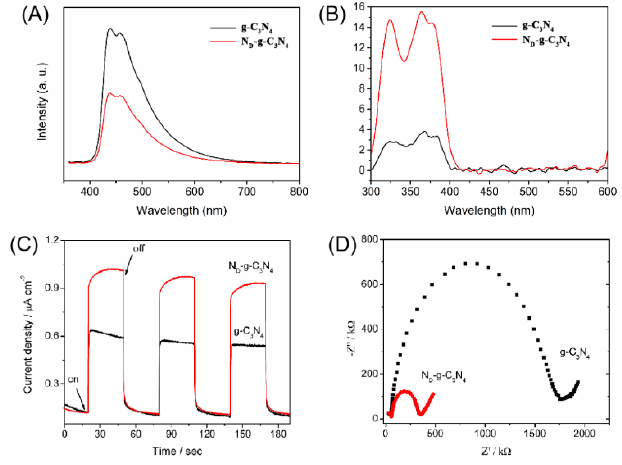
Figure 9. ( A ) PL spectra, ( B ) SPV spectra, ( C ) Photocurrent respons, and ( D ) Electrochemical impedance spectra of the samples.